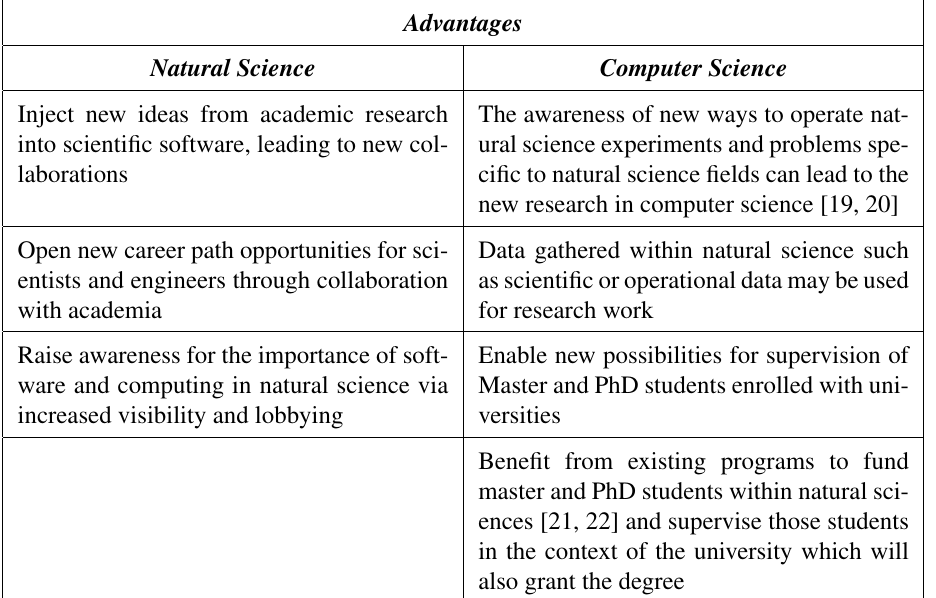
Table 1. Potential advantages and risks for the partners in a software